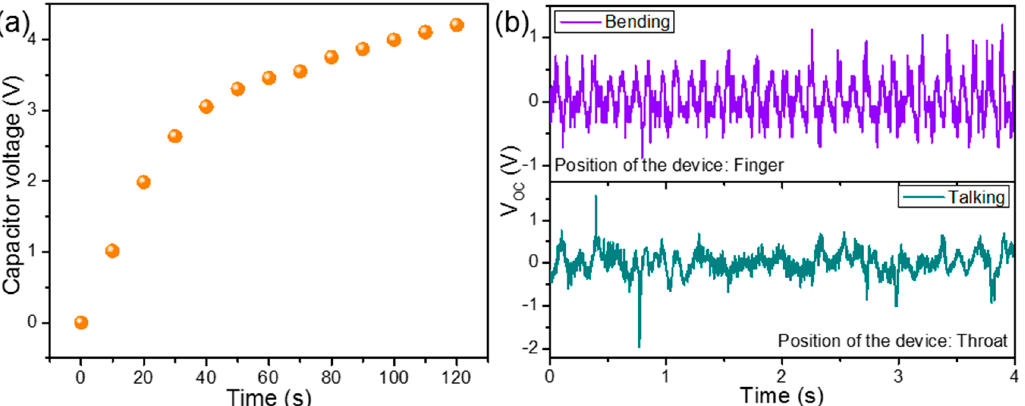
Figure 12. ( a ) Capacitor charging by using the rectified electricity from NPVDFH device upon repeated human finger tapping on it for a certain period of time. ( b ) Output V OC from the NPVDFH device during various human body movement activities (after attaching the device with respective body parts).